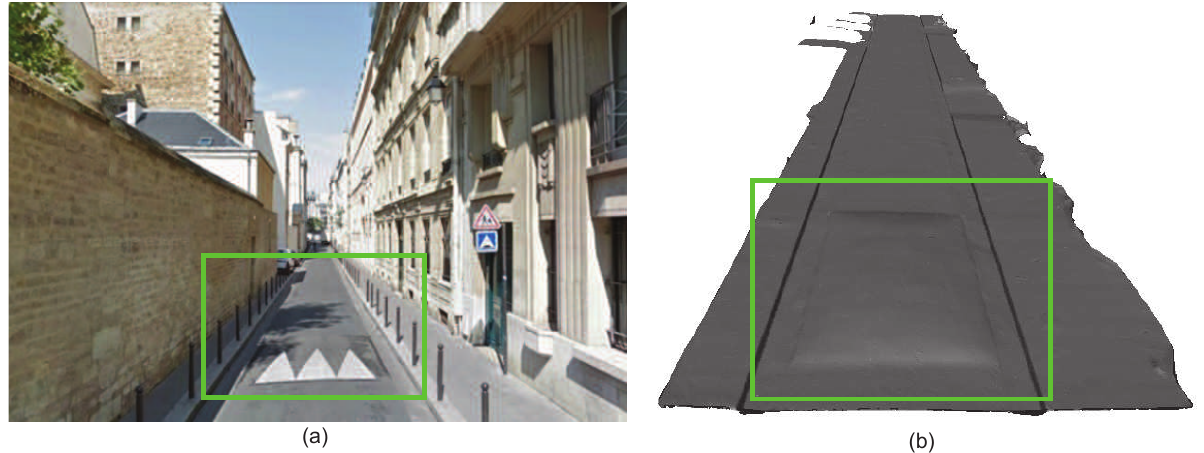
Figure 5: Surface reconstruction results for the dataset Urban ♯ 2 over 51 m length. (a) Google street view of the surveyed area (although not exactly the same pose, it is useful for surface inspection purposes), (b) N p = 1 . 01 Mpts, N t = 2 . 026 MTriangles, decimated mesh with f D = 90% , N D = 203 kTriangles. t